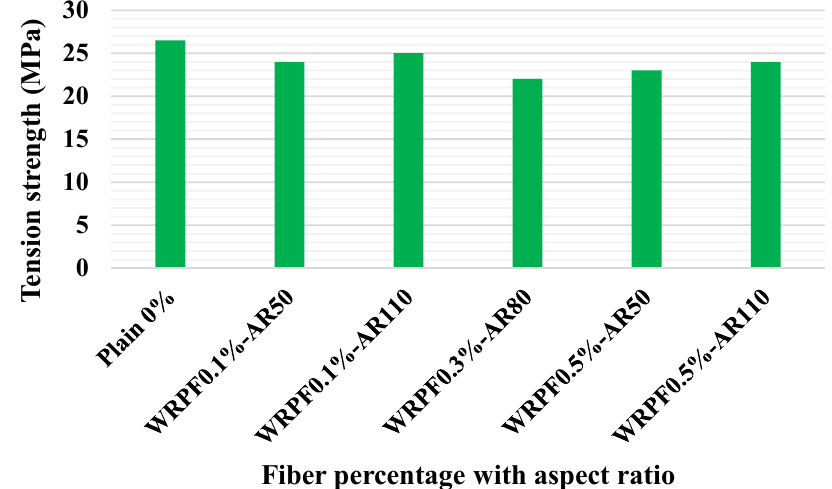
Figure 11. Ultimate STS of control samples and WRPFs concrete with various fiber aspect ratios [75]. Waste recycled plastic fiber (WRPF); aspect ratio (AR).